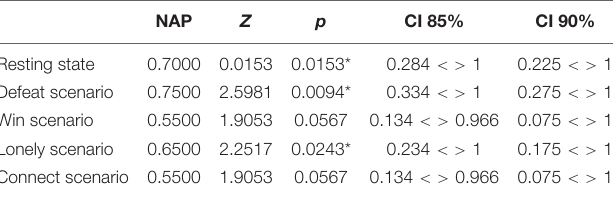
TABLE 3 | HRV (RMSSD in ms) during resting state at four assessment times. TABLE 4 | Non-overlapping data analysis of HRV during baseline and the four different